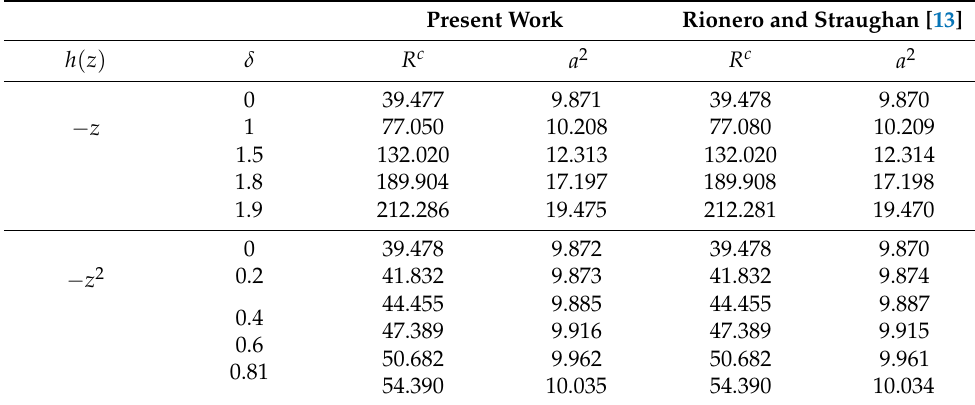
Table 1. Effect of R c and a 2 with δ with Q = Da = Rs = 0 for two types of gravity scenarios. Present Work Rionero and Straughan [13]